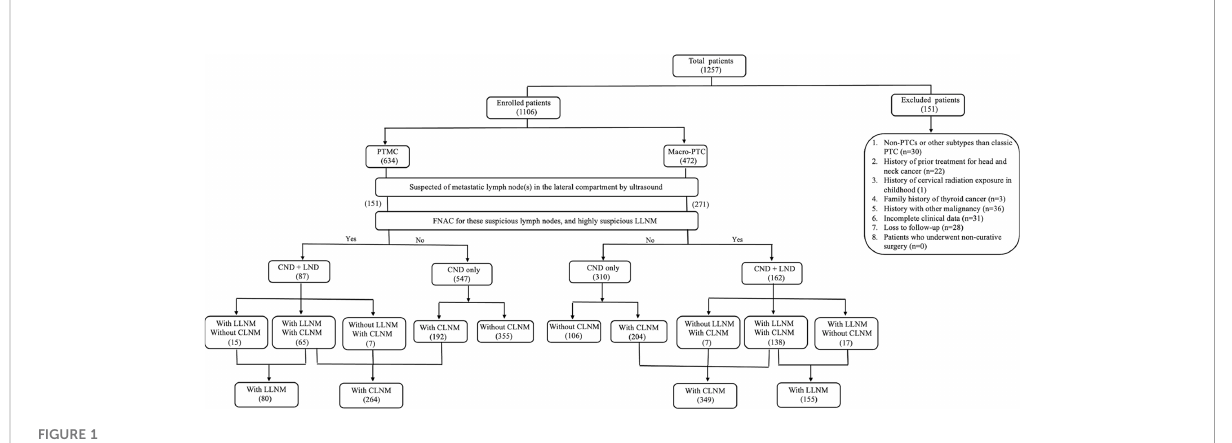
FIGURE 1 Flowchart of the patients enrolled in this